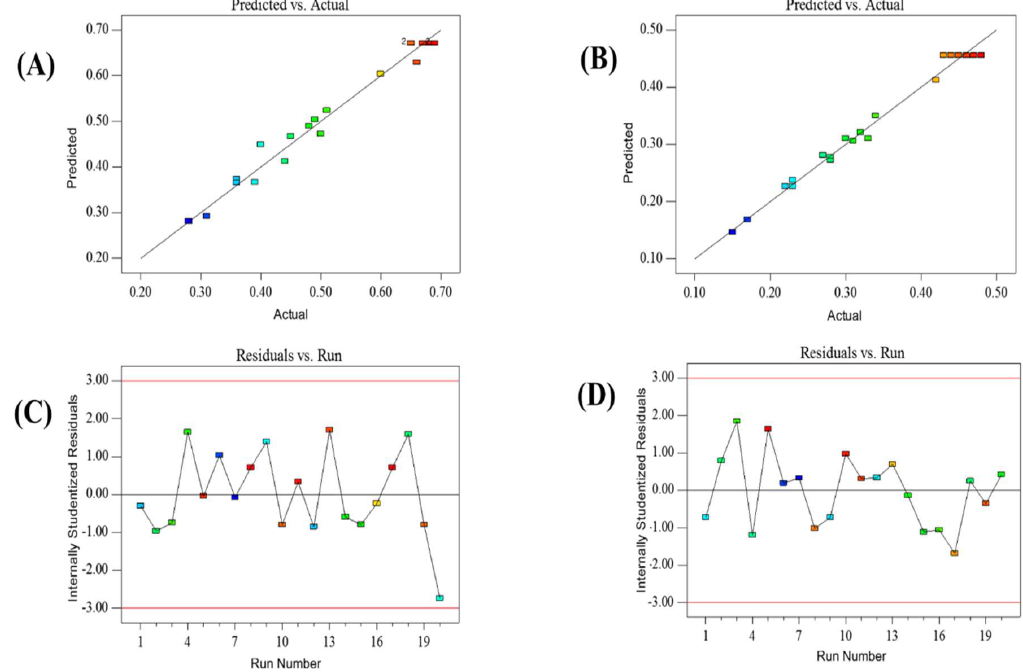
Figure 2. Diagnostic plots for model adequacy. ( A ) predicted versus actual of the yields of flavonoids; ( B ) predicted versus actual of the yields of ginkgolides; ( C ) internally studentized residuals of the yields of flavonoids; and, ( D ) internally studentized residuals of the yields of ginkgolides.